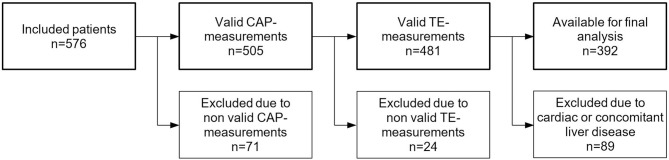
Flow chart of study inclusion.